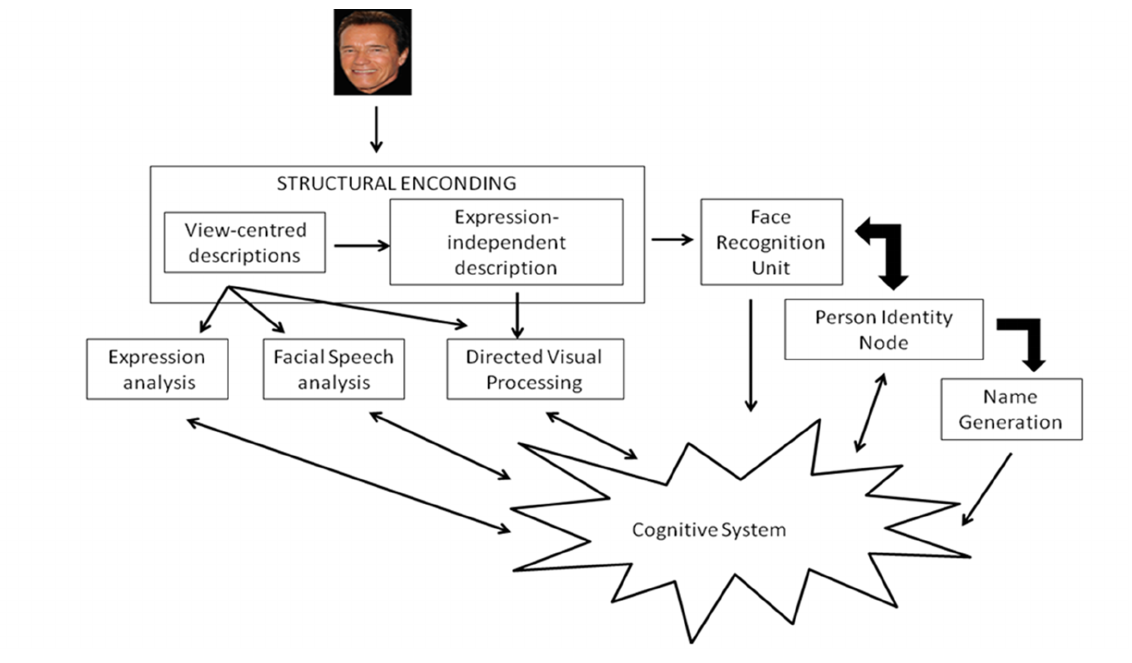
Bruce and Young’s model. Adapted from